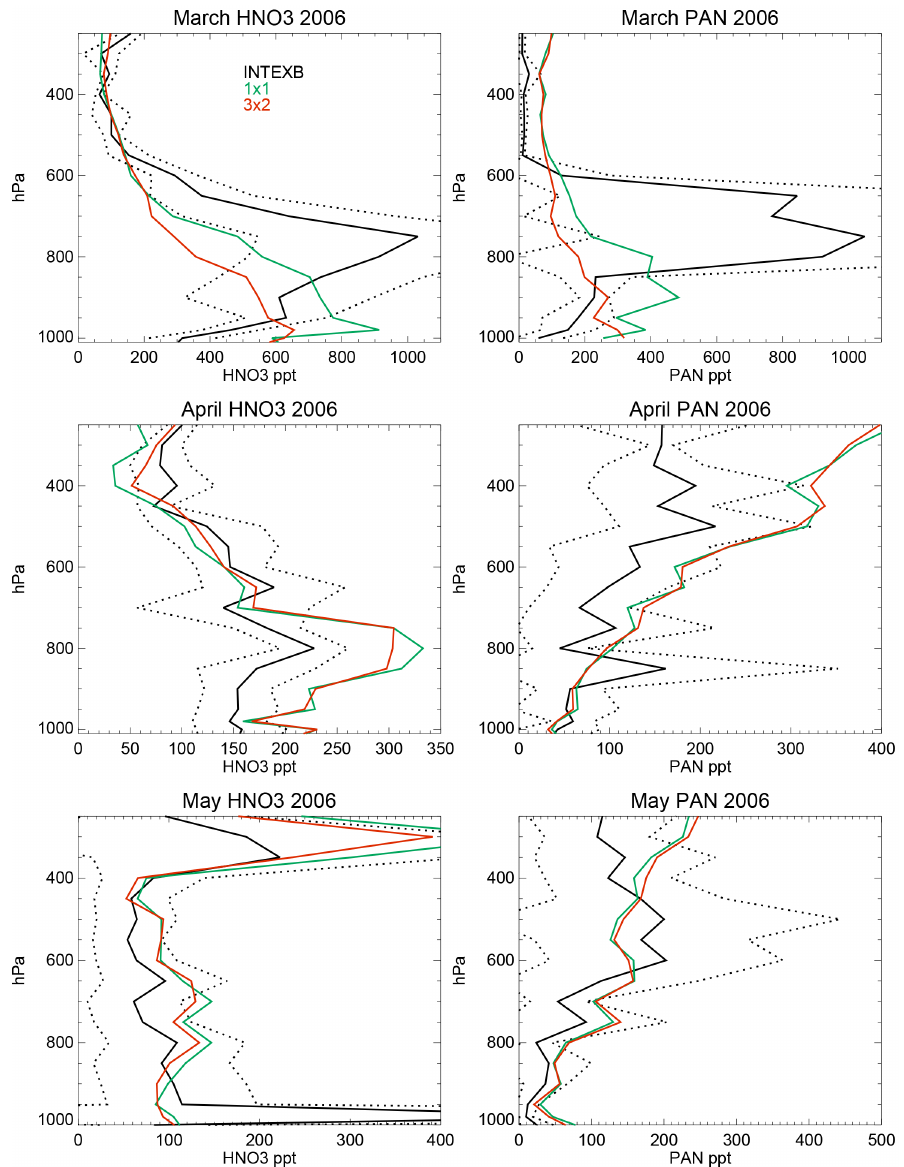
Figure 10. Monthly mean comparisons of HNO 3 (left) and PAN (right) from the INTEX-B measurements and TM5-MP simulations. The dotted line represents the 1 σ deviation in the mean of the measurements. For details of the locations for each month the reader is referred to Singh et al.